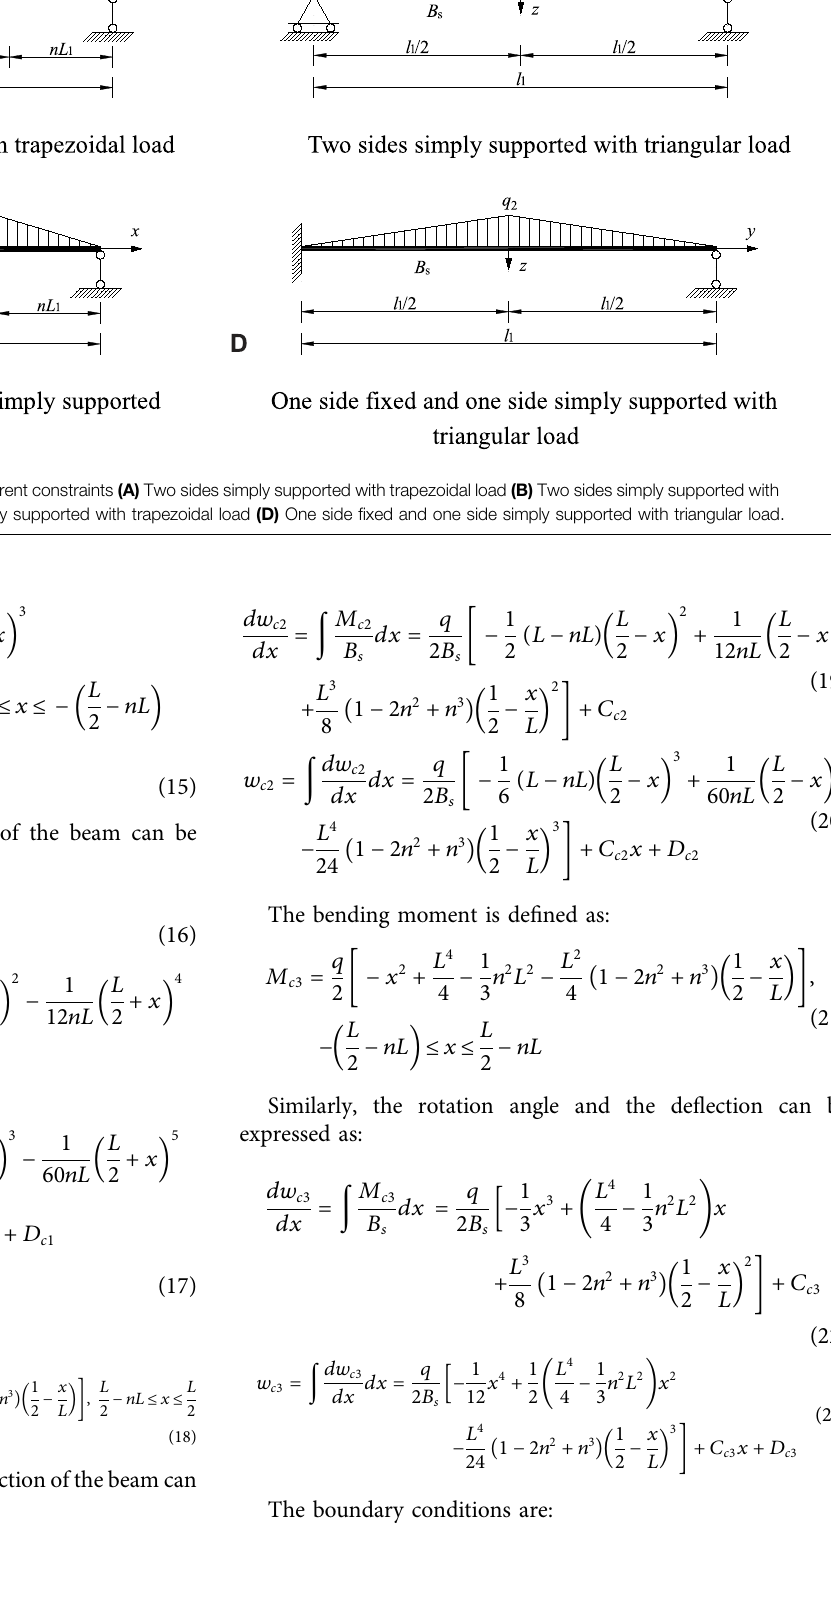
Frontiers in Built Environment |